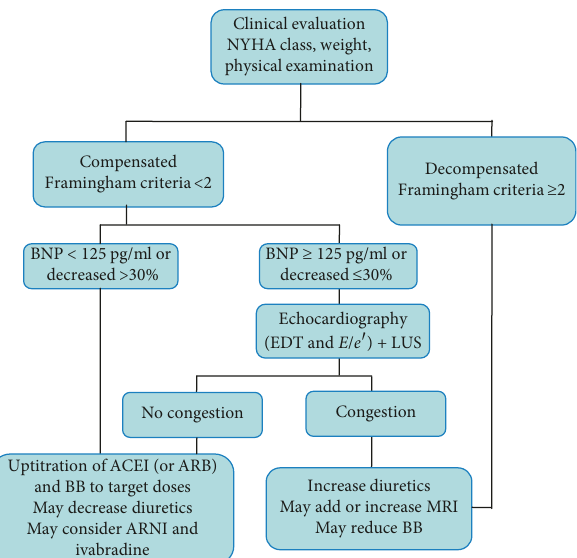
Figure 1: Predefined titration protocol. ACEI: angiotensin-con- verting enzyme inhibitors; ARB: angiotensin receptor blockers; ARNI: angiotensin receptor neprilysin inhibitors; BB: beta- blockers; BNP: B-type natriuretic peptide; EDT: E-wave de- celeration time; E / e : ratio of E /averaged myocardial early velocity; MRI: mineralocorticoid receptors inhibitors; LUS: lung ′